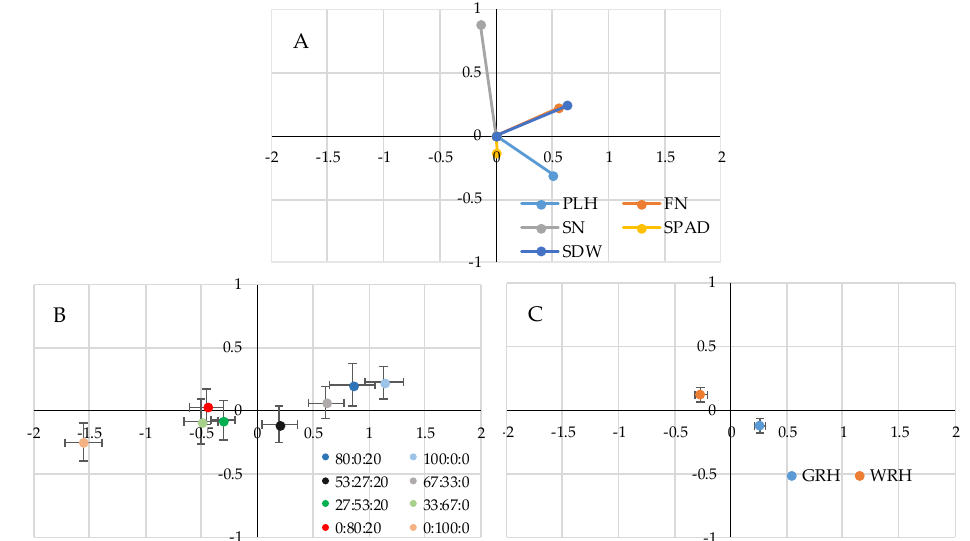
Figure 5. The plot ( A ) shows the weights for the principal components of the analysis for the 5 parameters measured for each rose plant. In the other plots, the centroids and their standard errors in the two dimensions for each classification factor are plotted. ( B ) classified using the P:RH:ADR ratio (% v:v:v); ( C ) whole or grinded RH (WGH and GRH, respectively). PLH, FN, SN, SPAD, and SDW = plant height, flower number, shoot number, SPAD value, and shoot dry weight, respectively.